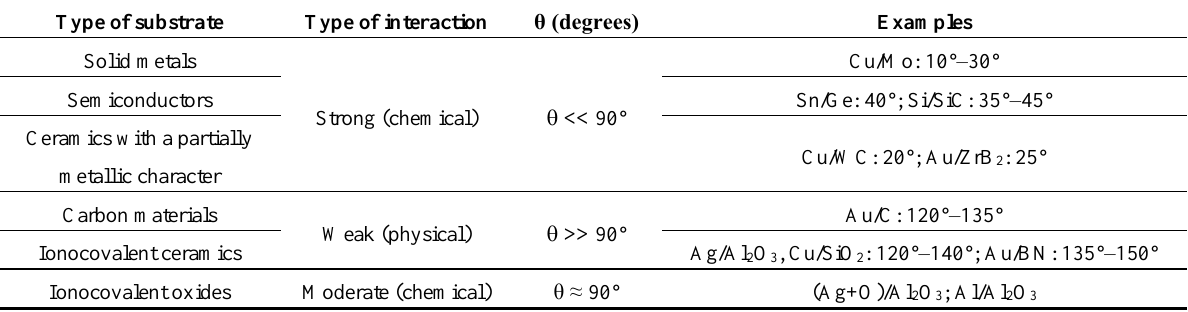
Table 1. Wetting of different types of solids by non-reactive liquid metals at temperatures close to the metal melting point. The contact angle values are from the review